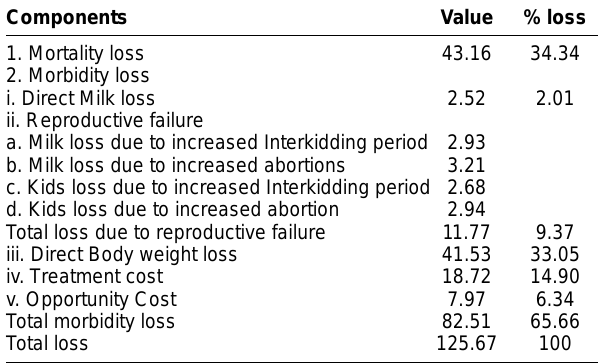
Table-5. Component and species wise losses due to PPR in goats (Rs. In lacs) Components